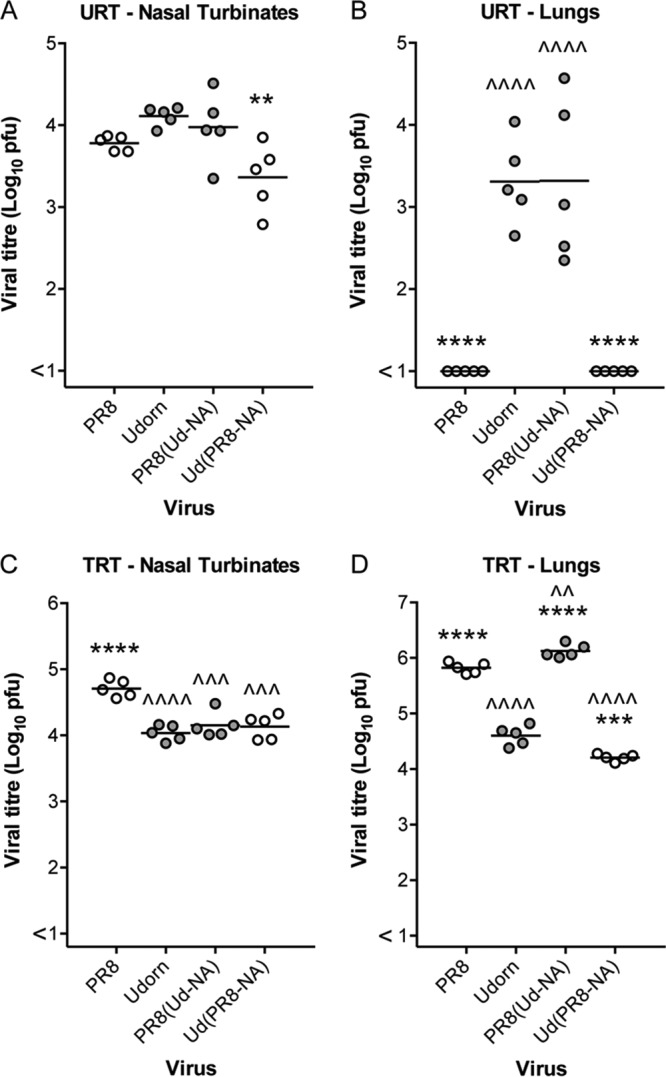
Viral titers in the nasal turbinates and lungs of mice infected with NA hybrid viruses. BALB/c mice were infected with 104.5 PFU of NA hybrid and parent viruses via either the URT (A and B) or TRT (C and D) route. After 4 days, nasal turbinates (A and C) and lungs (B and D) were removed, and viral titers in homogenates were determined by plaque assay on MDCK cell monolayers. Individual titers (circles) and the mean viral titers of 5 mice per group (horizontal lines) are shown, expressed as titers per organ. Filled circles, viruses containing Udorn NA; open circles, viruses containing PR8 NA. Compared to PR8, ^^, P < 0.01; ^^^, P < 0.001; and ^^^^, P < 0.0001. Compared to Udorn, **, P < 0.01; ***, P < 0.001; and ****, P < 0.0001.